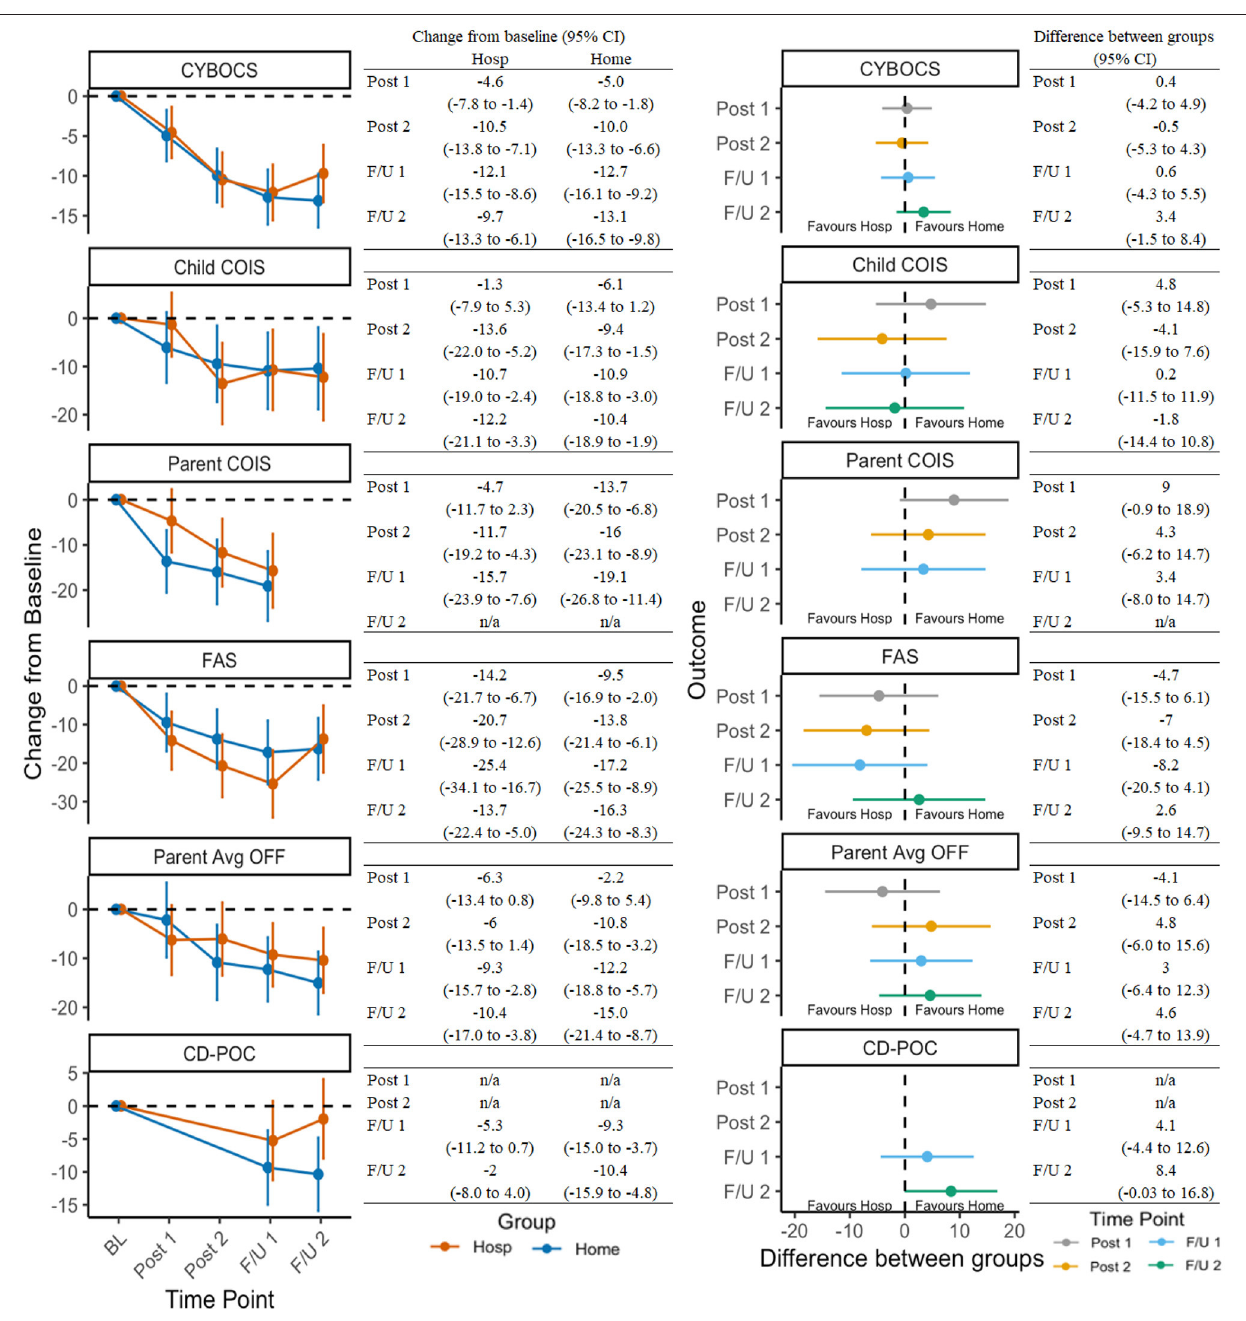
FIGURE 2 | Change in OCD-related outcomes across timepoints and between groups. See Table 1 for a list of all measure